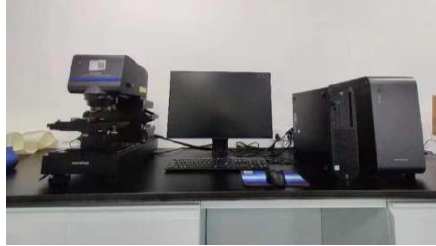
Figure 10. Laser microscope.